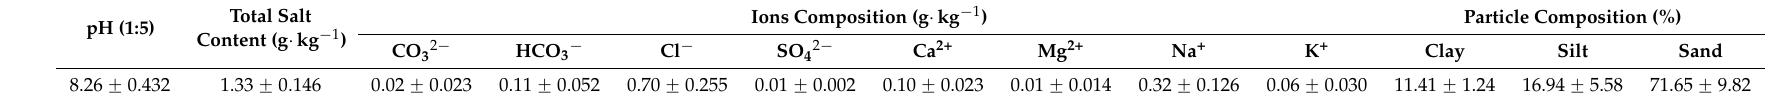
Table 1. Physicochemical properties of the shifting Aeolian sand in the study area.